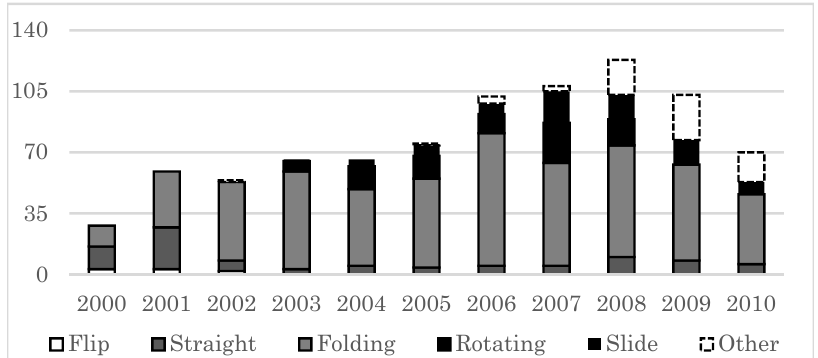
Figure 7. The bar chart of mobile phone design type Note: Data for 2008 was created from the Mobile Content Forum (2008, 2009), and data for 2009 was created from the Mobile Content Forum (2009, 2010). Data through September 2010 was used to make this graph. Further, it should be noted that this graph contains some smartphone data. Source: Retrieved from Mobile Content Forum (2008, 2009, 2010,